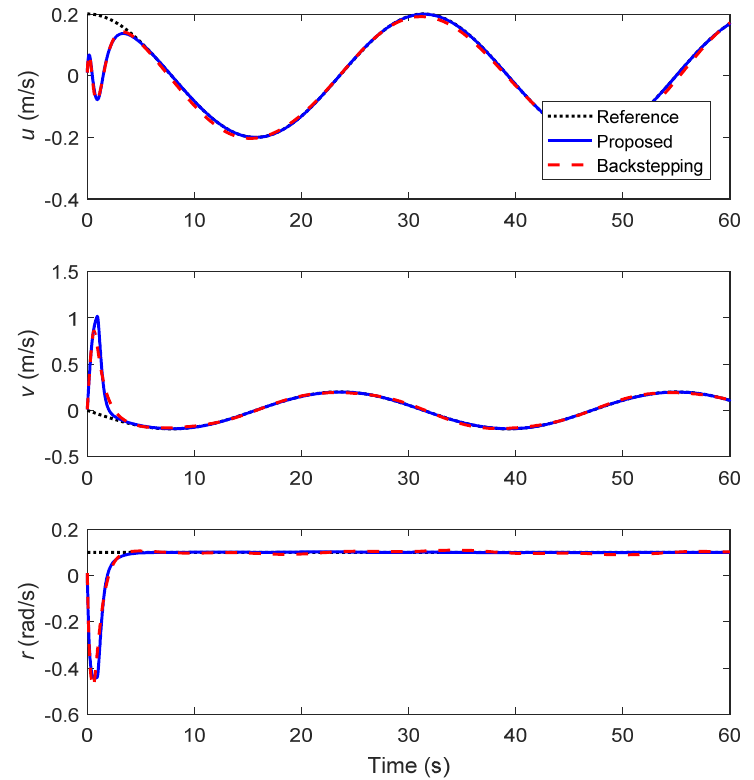
Figure 5. Profile of the velocity tracking (Case 1).